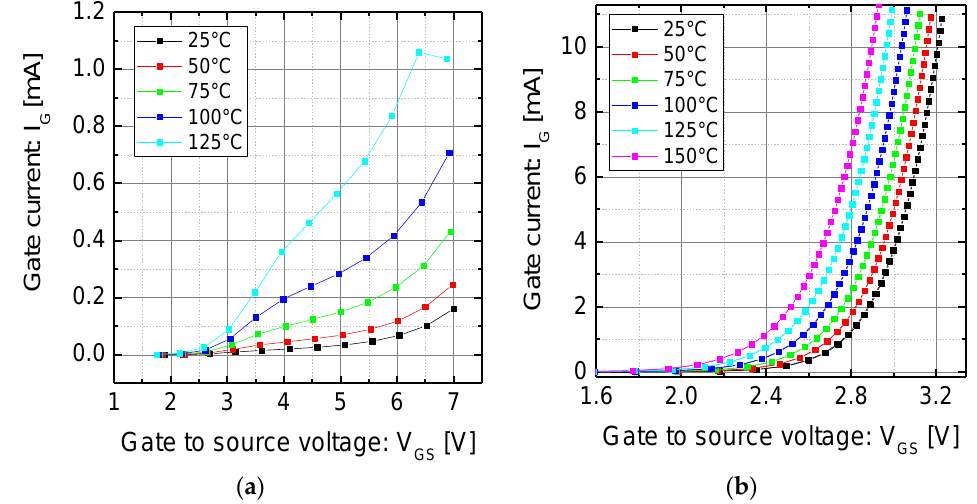
Figure 5. Experimental gate current at various temperatures as a function of the gate-to-source voltage when drain and source are short-circuited for ( a ) DUT_S and ( b ) DUT_O.